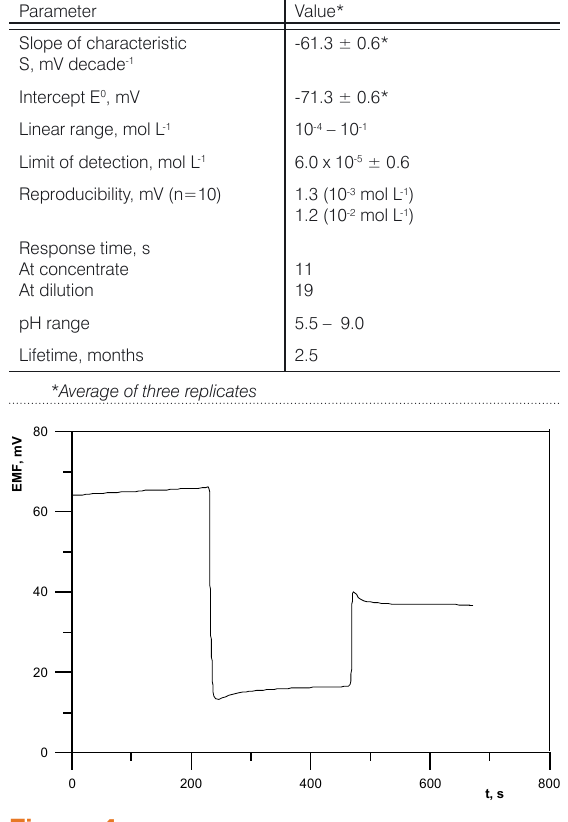
Figure 4. Response time of ISE-2.